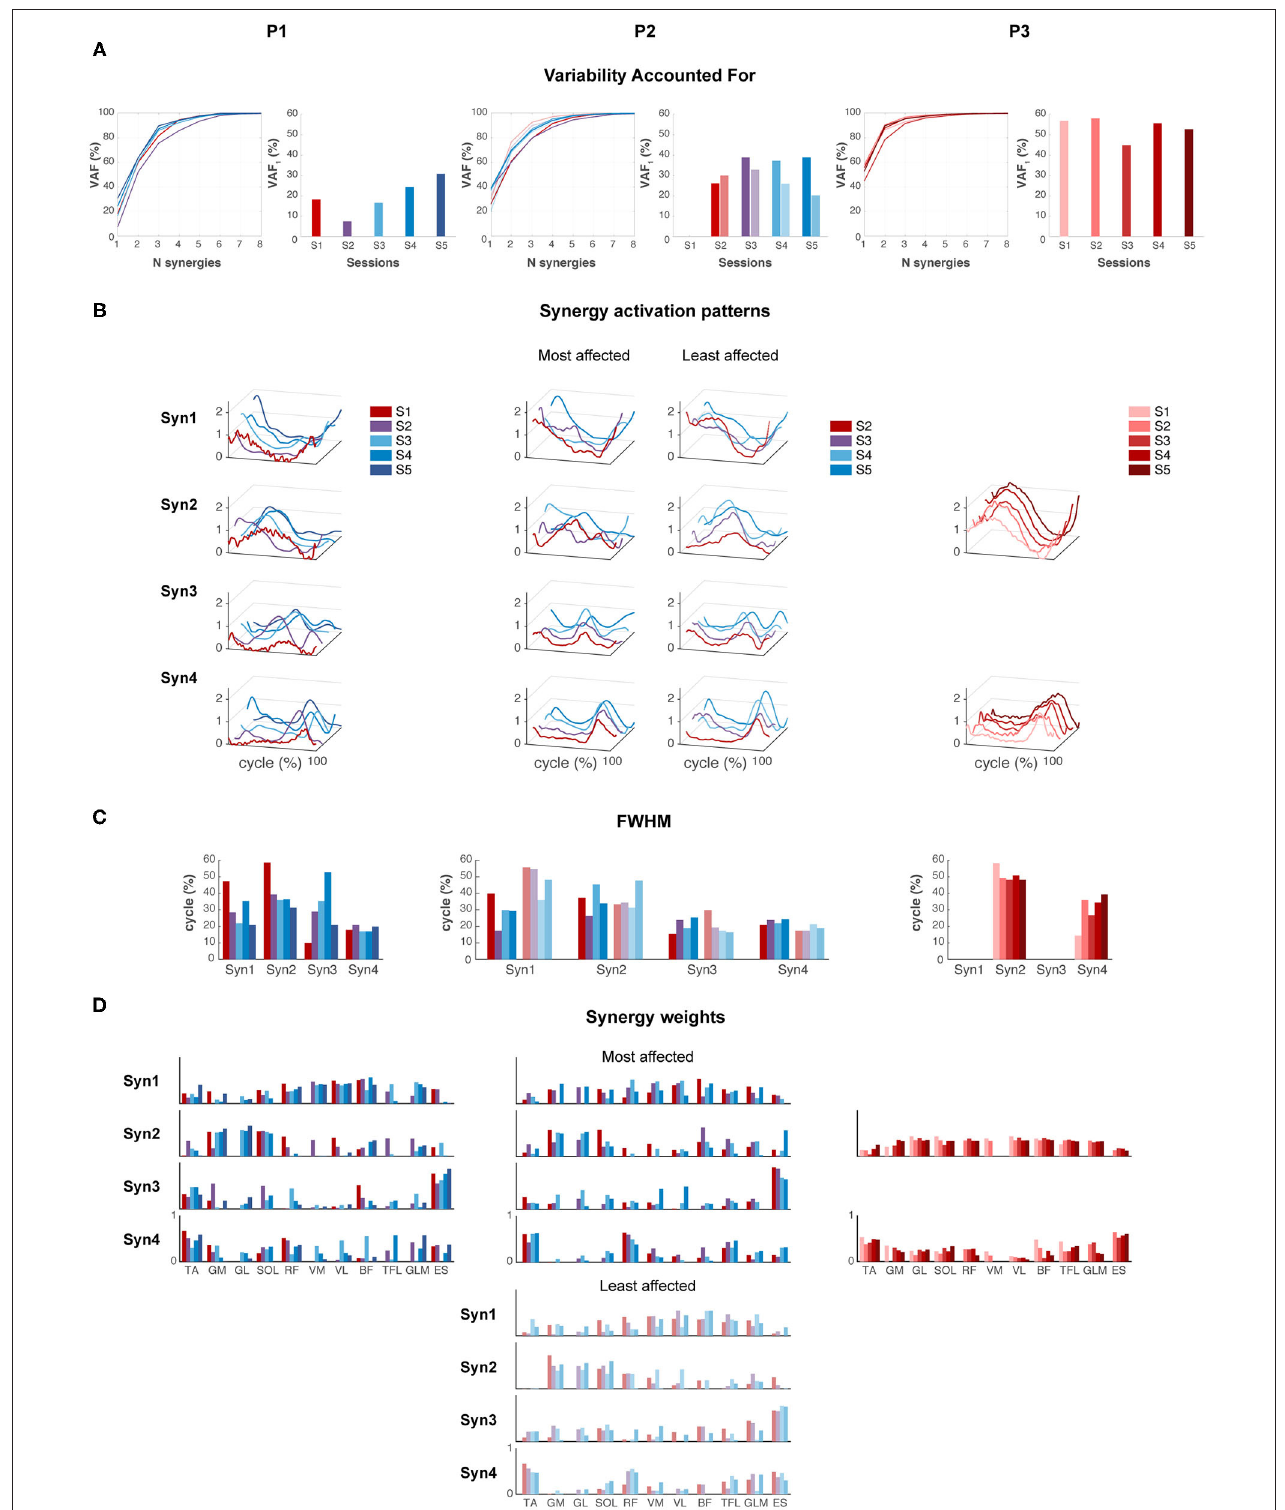
FIGURE 5 | Muscle synergies. (A) Variability accounted for (VAF) by one to eight synergies, and for the first synergy (VAF1). (B) Synergy activation patterns for a fixed number of synergies: four for P1 and P2, and two for P3. (C) Full-width of the half maximum (FWHM) per muscle synergy. (D) Synergy weights: contribution of each muscle to each synergy across